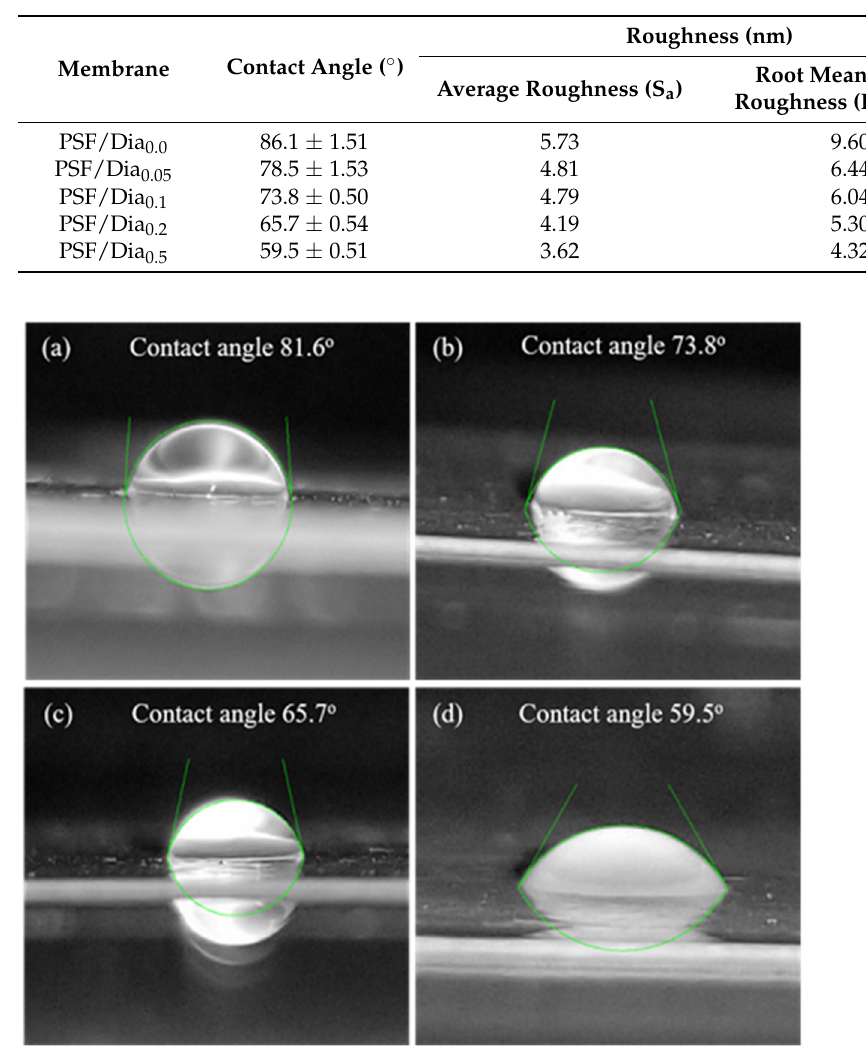
Figure 5. Image of water droplets on different membrane surfaces and their contact angle values. ( a ) Control membrane (PSF/Dia 0.0 ) and composite membranes with different % of diatomite material: ( b ) PSF/Dia 0.1 , ( c ) PSF/Dia 0.2 , and ( d ) PSF/Dia 0.5